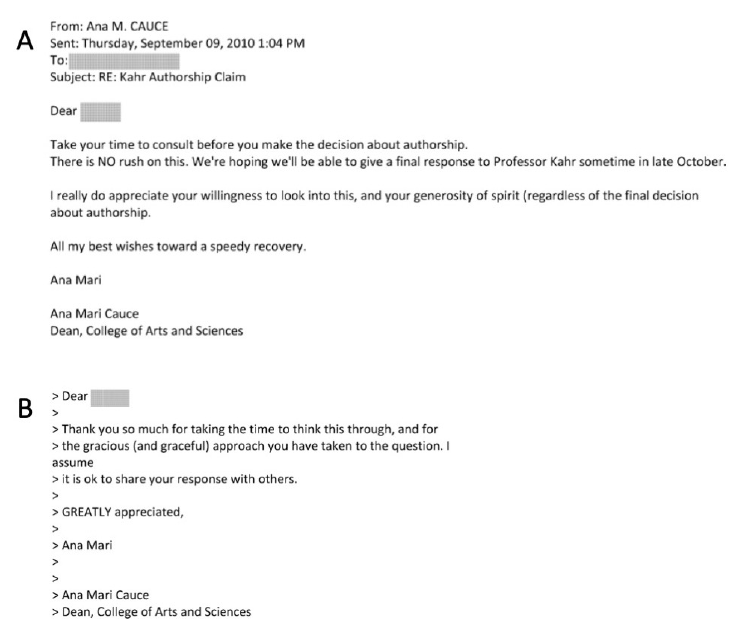
Figure 10: Emails from A. M. Cauce to L. R. Dalton, 2010 September 9, during a scientific misconduct inquiry. Cauce asks Dalton whether he published a paper 7 about something he did not invent in the same journal in which he had previously reported the results of “ENP. 6 Dalton later conceded that he did publish misappropriated research in 2004, but he blamed his students.